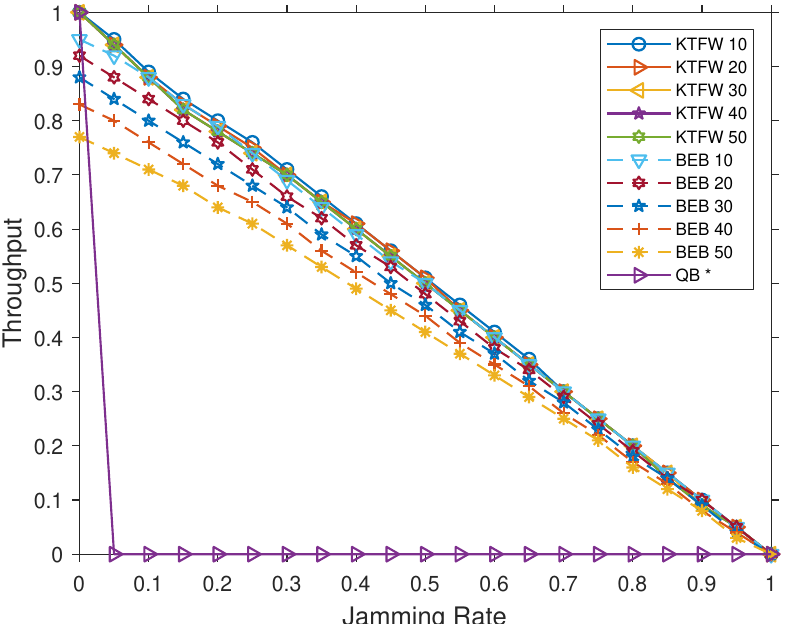
Figure 9. Comparing the throughput of the KTFW and the BEB algorithms for all jamming rates and n ∈ [10–50].